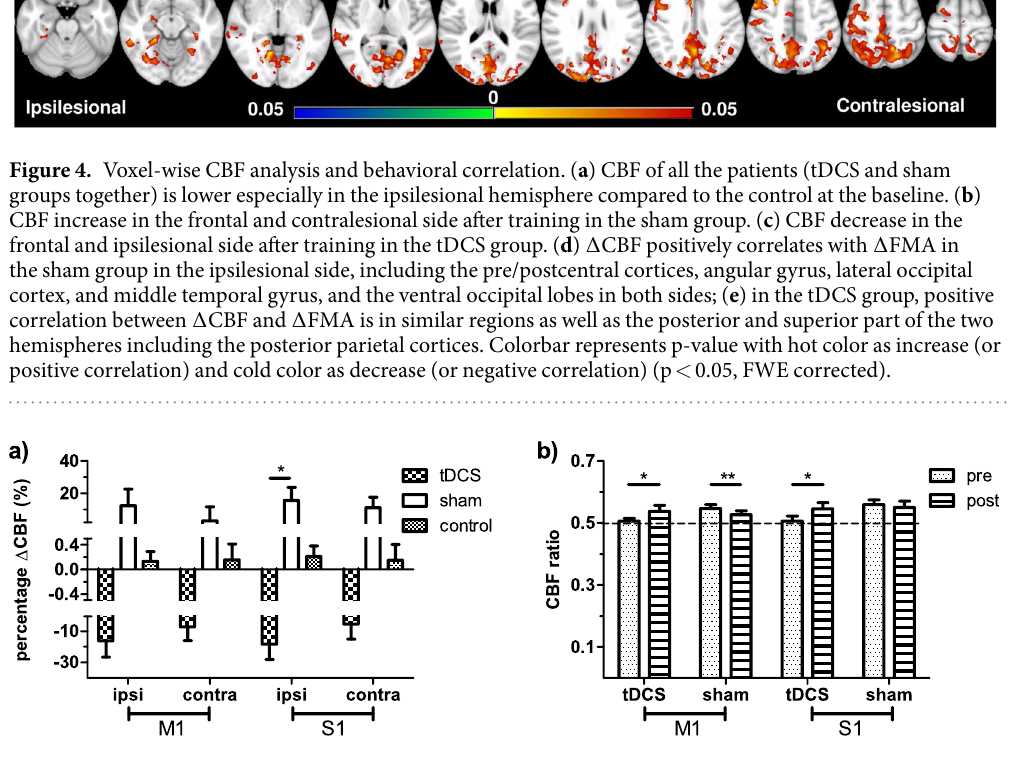
found in S1. The CBF change after intervention in the patient groups was much larger than that seen in the con- trol group, and significantly different between the sham and tDCS groups in the ipsilesional somatosensory cortex (p = 0.0186).